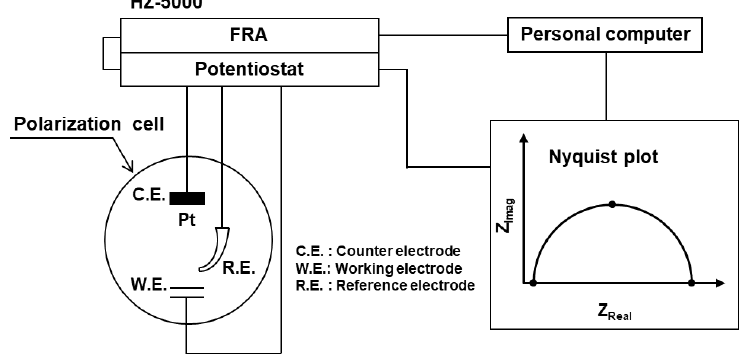
Figure 2. Experimental apparatus used for electrochemical impedance measurement. 167